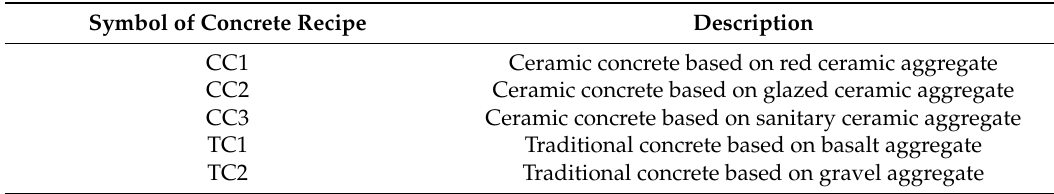
Table 4. Symbols of the tested concrete